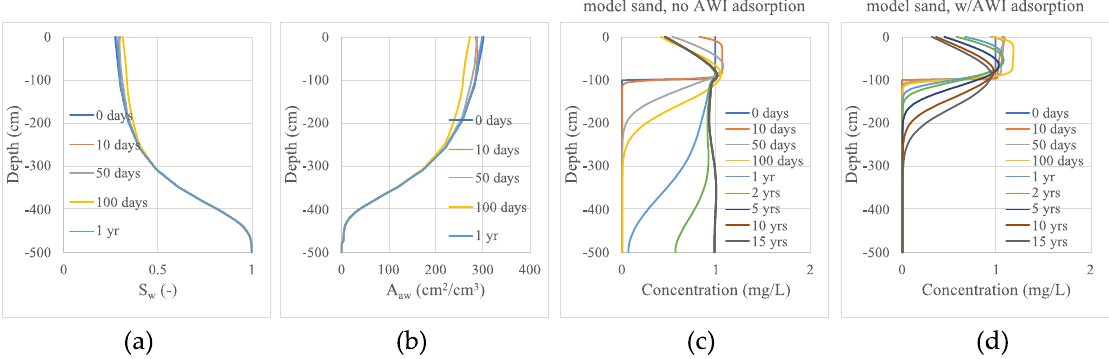
Figure 7. Simulated response and concentration profiles for the transport of PFOS leaching from a source area within a quartz sand vadose zone: ( a ) temporal change in S w ; ( b ) temporal change in A aw ; ( c ) PFOS concentration profiles for solid-phase sorption but no AWI adsorption; PFOS concentration profiles for case where both solid-phase sorption and AWI adsorption occur.